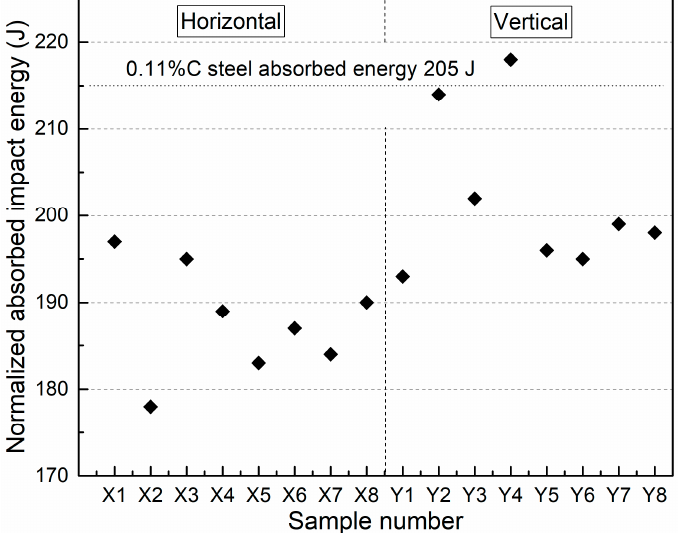
Figure 4. Absorbed impact energy in joules for horizontal and vertical specimens.